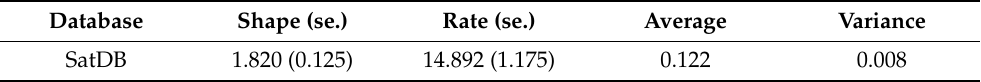
Table 1. Parameters of the gamma distribution obtained from the SatDB elephant